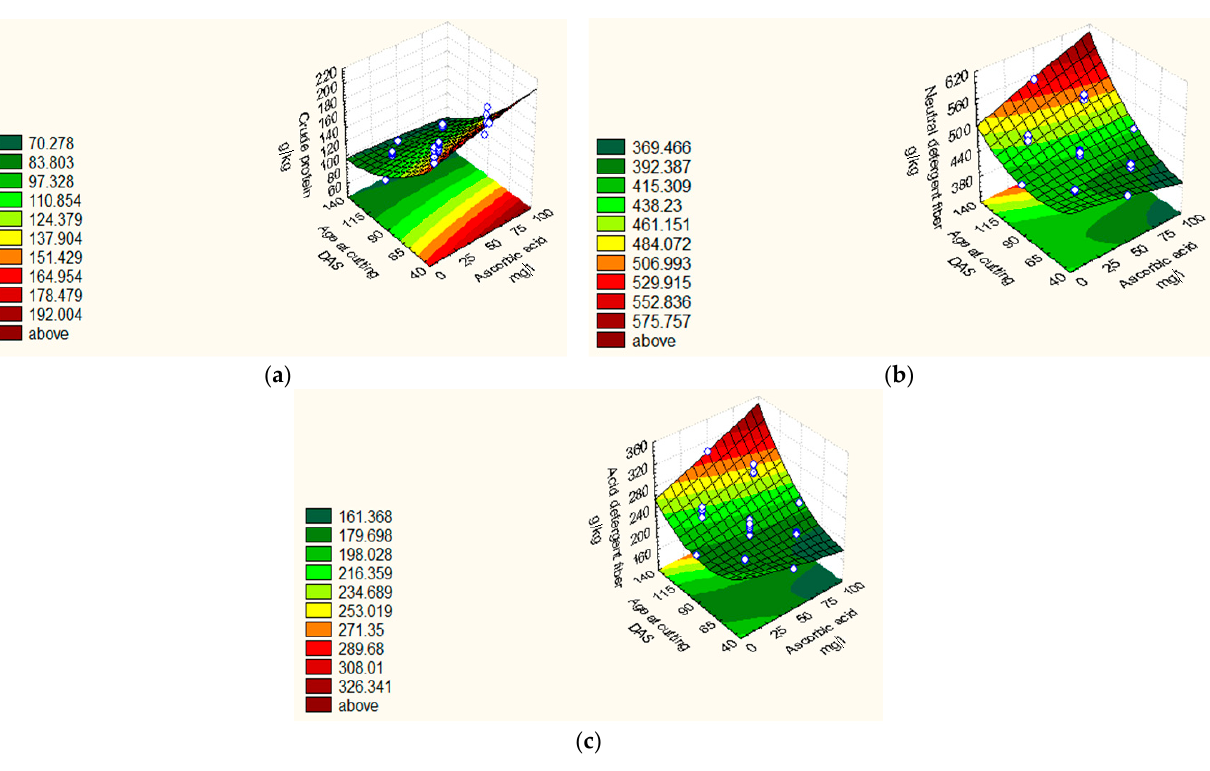
Figure 2. Response surface for crude protein ( a ) in 2018/19 and degraded neutral detergent fiber ( b ) in 2019/20 as affected by PF and AC at the central levels of AA and HA.